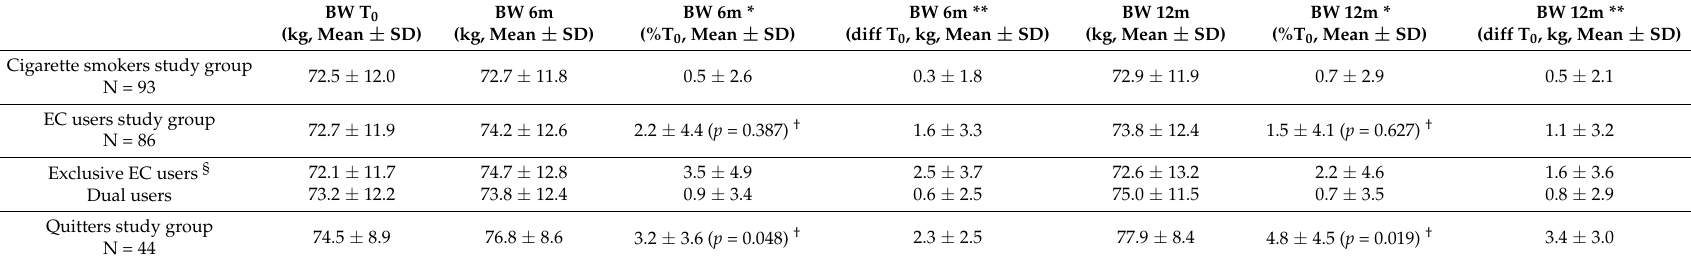
Table 2. Body weight (BW) at baseline (BW T0), 6 (BW 6m) and 12 months (BW 12m) and associated changes both in percent values and absolute